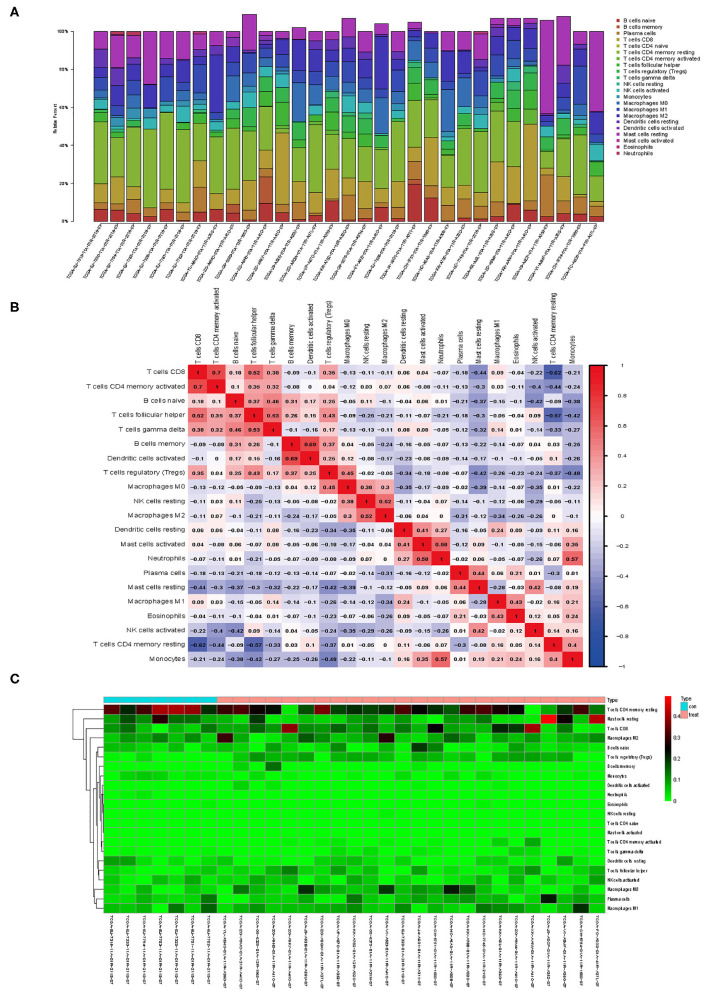
Landscape of immune cell infiltration in prostate cancer (PCa) tissues. (A) Bar charts of 22 immune cell proportions in PCa and normal tissues. (B) Correlation matrix of all immune cell proportions. (C) Heat map of the immune cell proportions between PCa and normal tissues. The standardized immune cell infiltration levels are depicted by the color gradient: green, low infiltration ratio; red, high infiltration ratio. Values in black represent a ratio equal to 0. Result visualization was performed by using R package ggplot2 (version 3.1.0). Correlation analysis and visualization were performed by using R package corrplot (version 0.84).